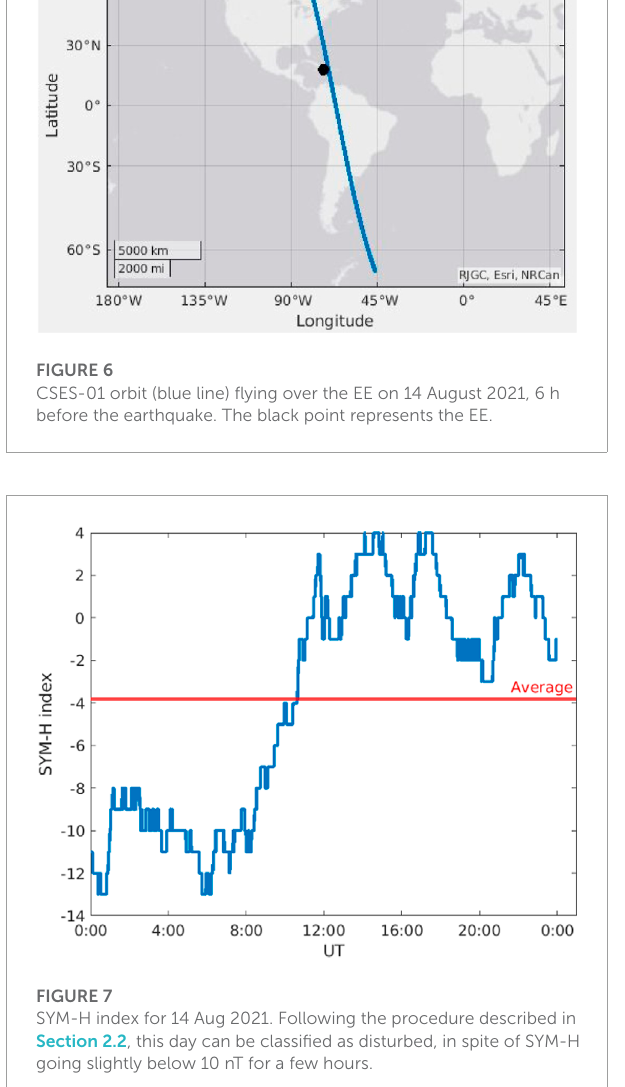
decomposition. FIF is a signal decomposition technique recently 2009; Cicone and Zhou, 2017), which has proven stable and convergent in the management of non-stationary signals (Cicone,